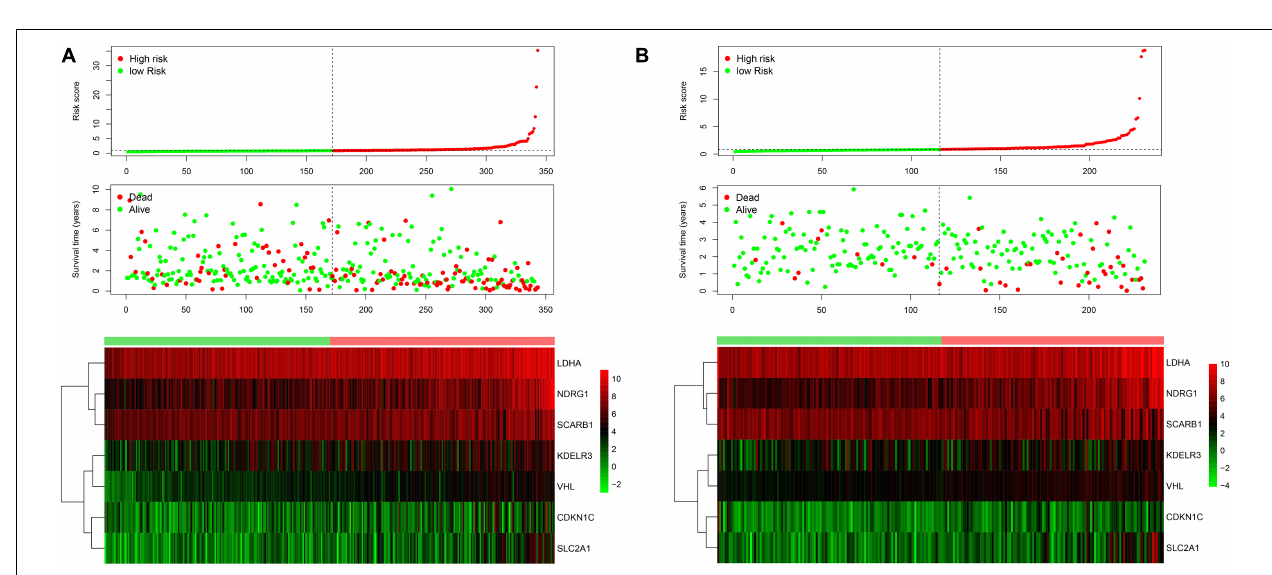
FIGURE 2 | The risk score distribution for each patient was showed in the training dataset (A) and external validation dataset (B) . The upper panel represent the risk score distribution, the middle panel showed the cases distribution and the lower panel. Exhibited the gene expression.